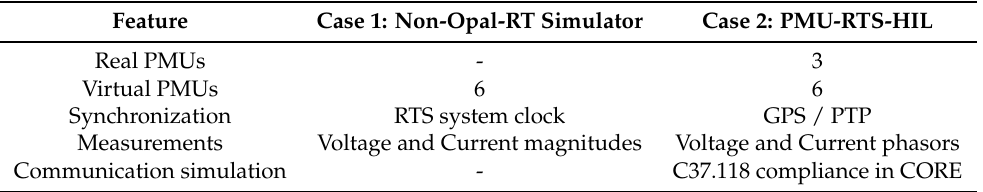
Table 3. IEEE 37-nodes test feeder modeling for fault detection under different platforms.